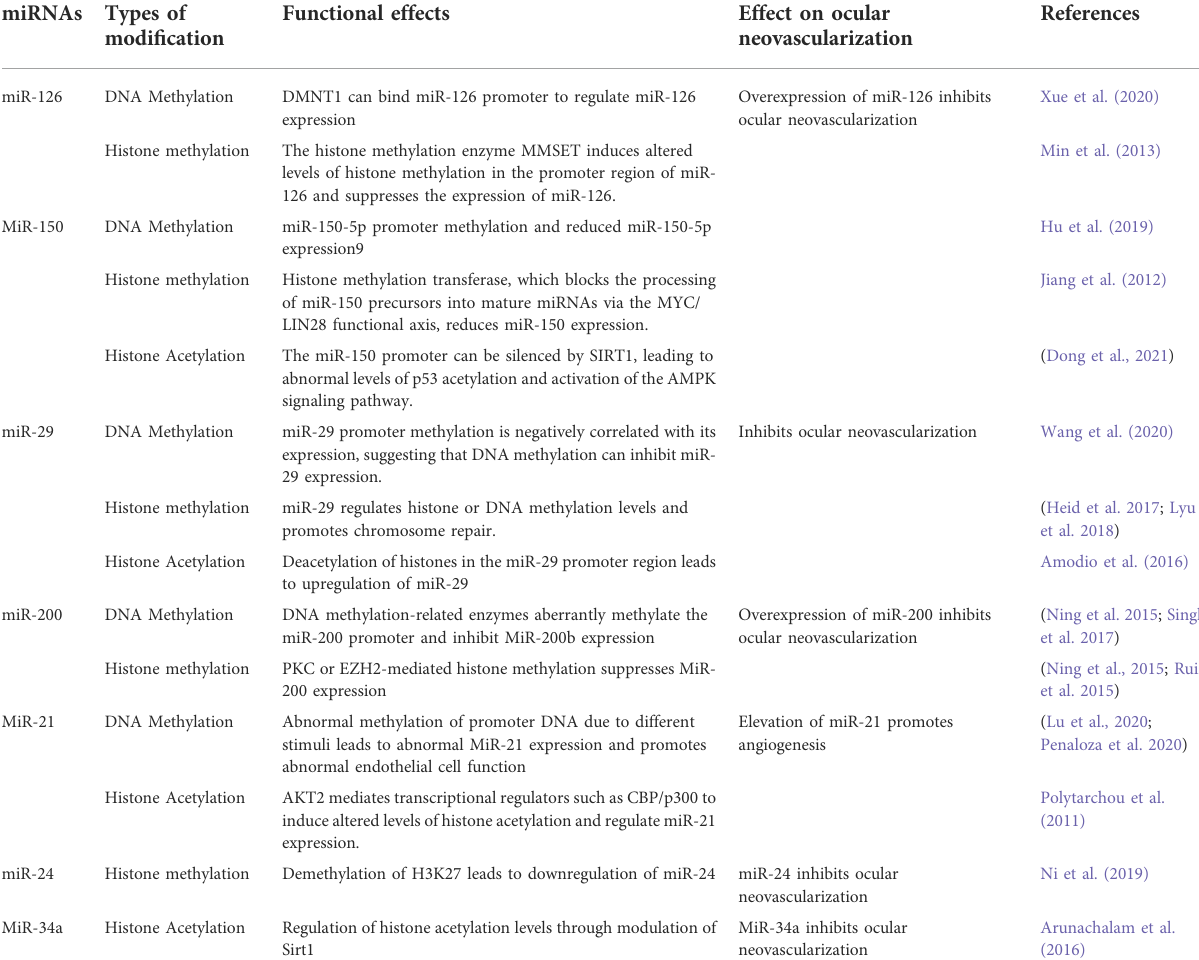
TABLE 3 Potential epigenetic regulatory networks involving ocular neovascular